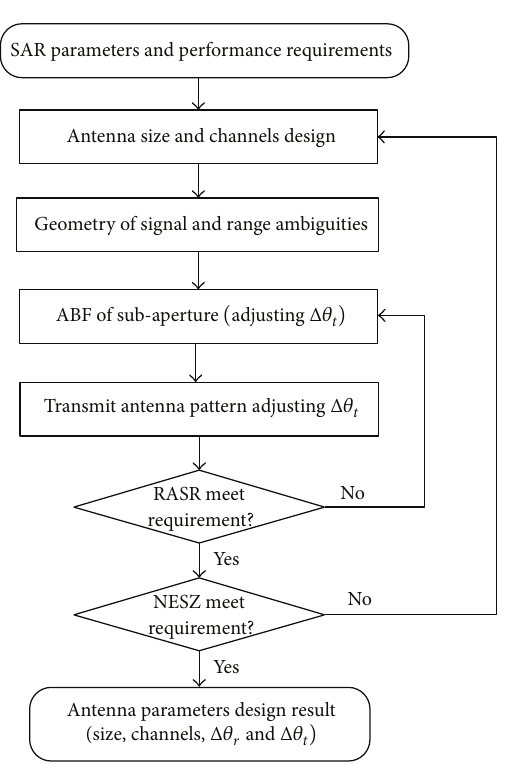
Figure 5: The block diagram of system design for ABF and DBF on receive in elevation.